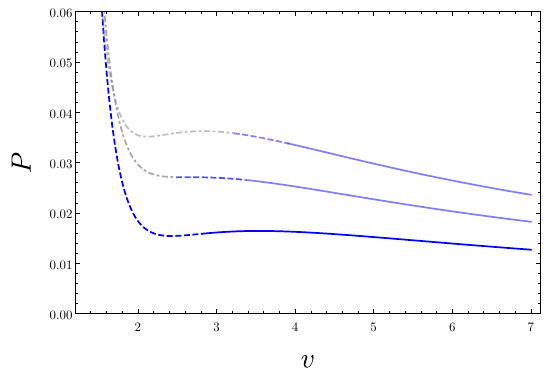
Figure 18 . Pressure vs. volume plot depicting two critical points in d = 5 for k = +1. This plot displays the situation for µ = 0 . 446 e 2 . There are two critical points with criti- − 0 . 160234 /e and T 0 . 163327 /e . The isotherms shown correspond to cal temperatures T c 1 ≈ c 2 ≈ 1 . 22 T , from bottom to top (more to less opacity). Solid blue lines indicate 0 . 75 T T c 1 , T c 1 , c 2 ≈ positive Wald entropy and mass, dashed blue lines indicate positive mass but negative Wald en- tropy, dot-dashed gray lines indicate negative mass and hence that the corresponding black holes do not